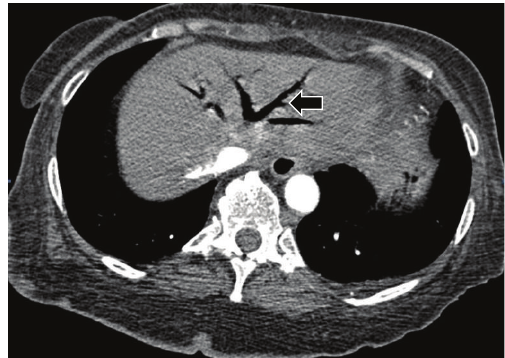
Figure 2: CT image of the liver shows air delineating the hepatic venous system ( arrow ).